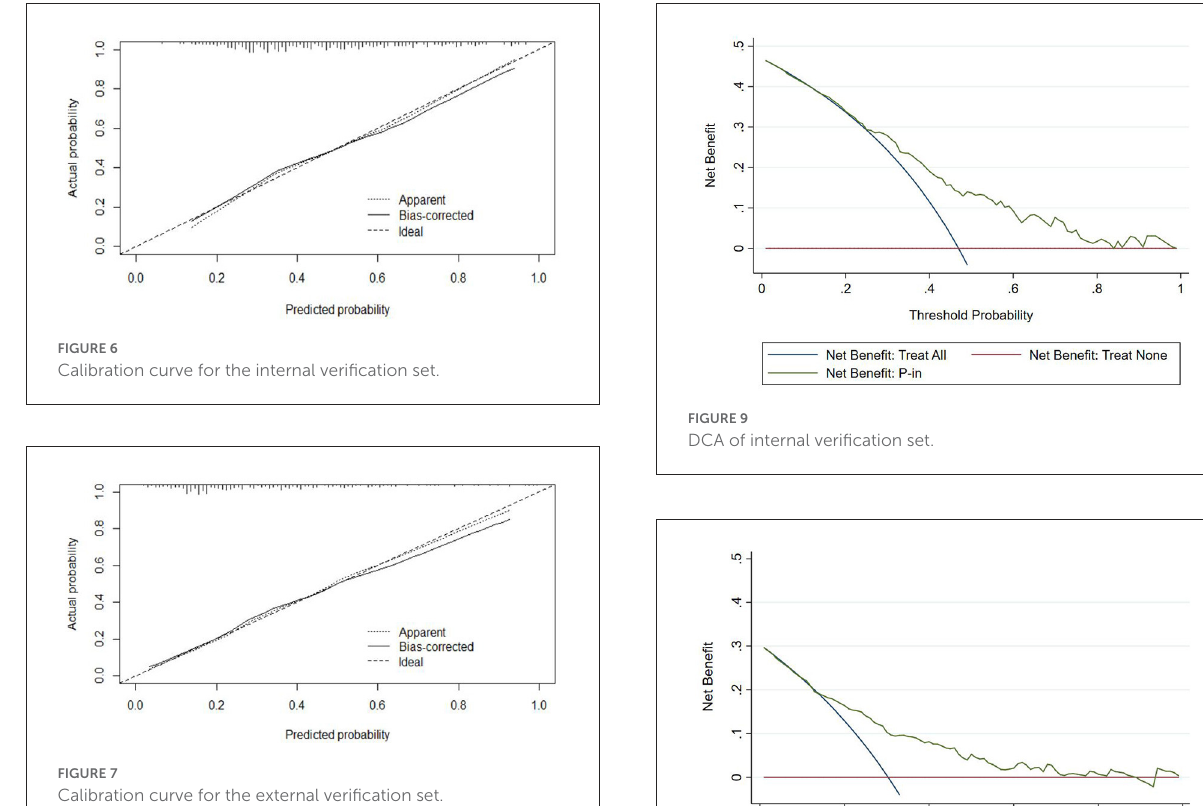
FIGURE7 Calibration curve for the external verification set.